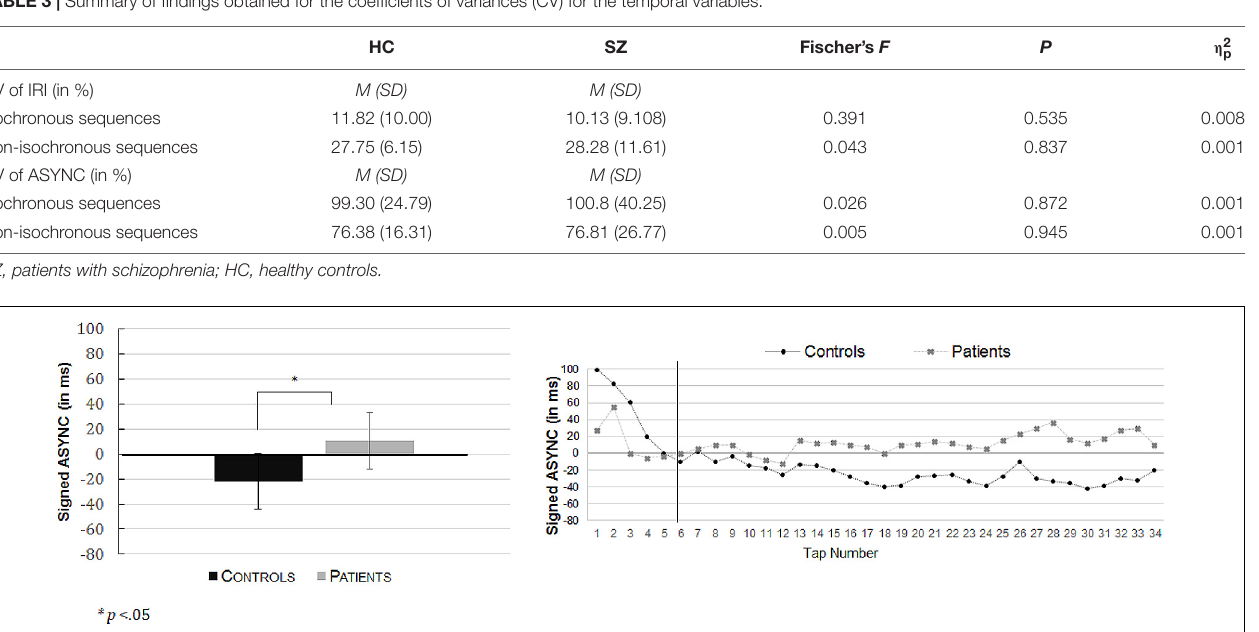
TABLE 3 | Summary of findings obtained for the coefficients of variances (CV) for the temporal variables.